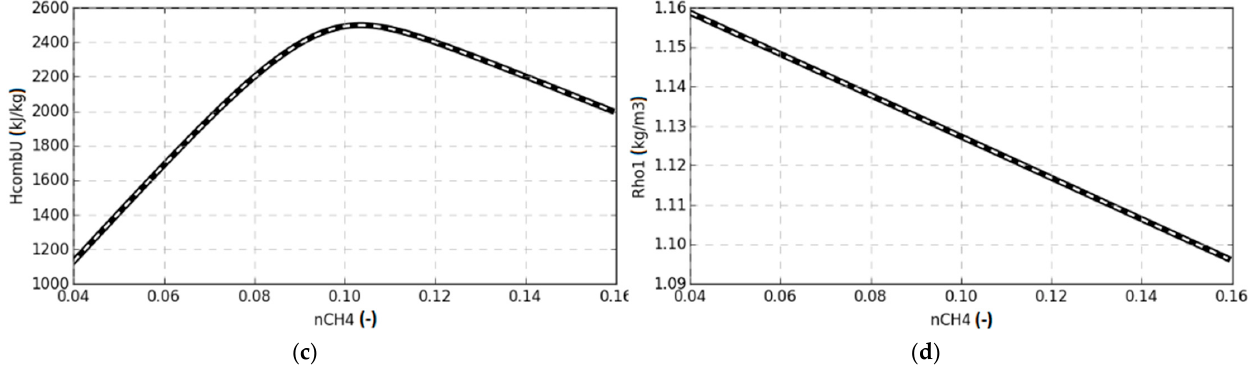
Figure 6. Example input data calculated with Cantera: ( a ) adiabatic flame temperature, ( b ) expansion ratio, ( c ) heat of combustion, and ( d ) unburned mixture density (solid lines) as a function of CH 4 fraction in air. Cantera generated data with 1–6th order polynomial fit curve (dashed lines). Data generated for initial temperature 293 K and pressure 1.01325 bar.